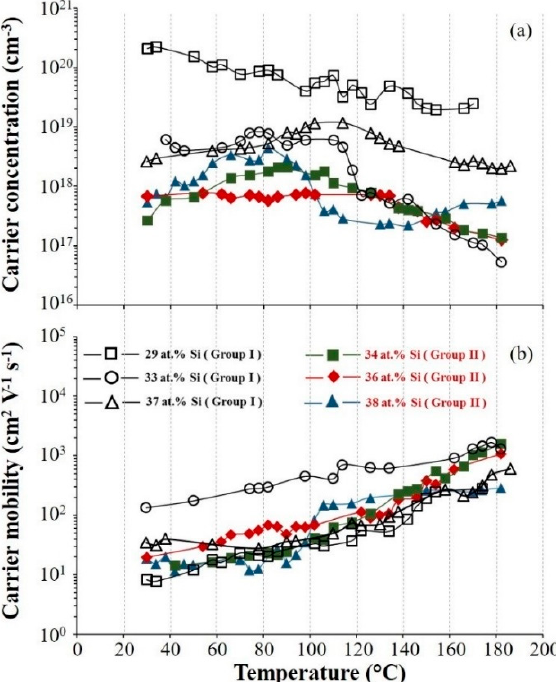
Figure 9. Carrier concentration ( a ) and carrier mobility ( b ) of Mg 2 Si films vs. temperature for different Si atomic concentrations. (Group I: R P < 7 × 10 − 4 Pa and Group II: R P ≥ 7 × 10 − 4 Pa).